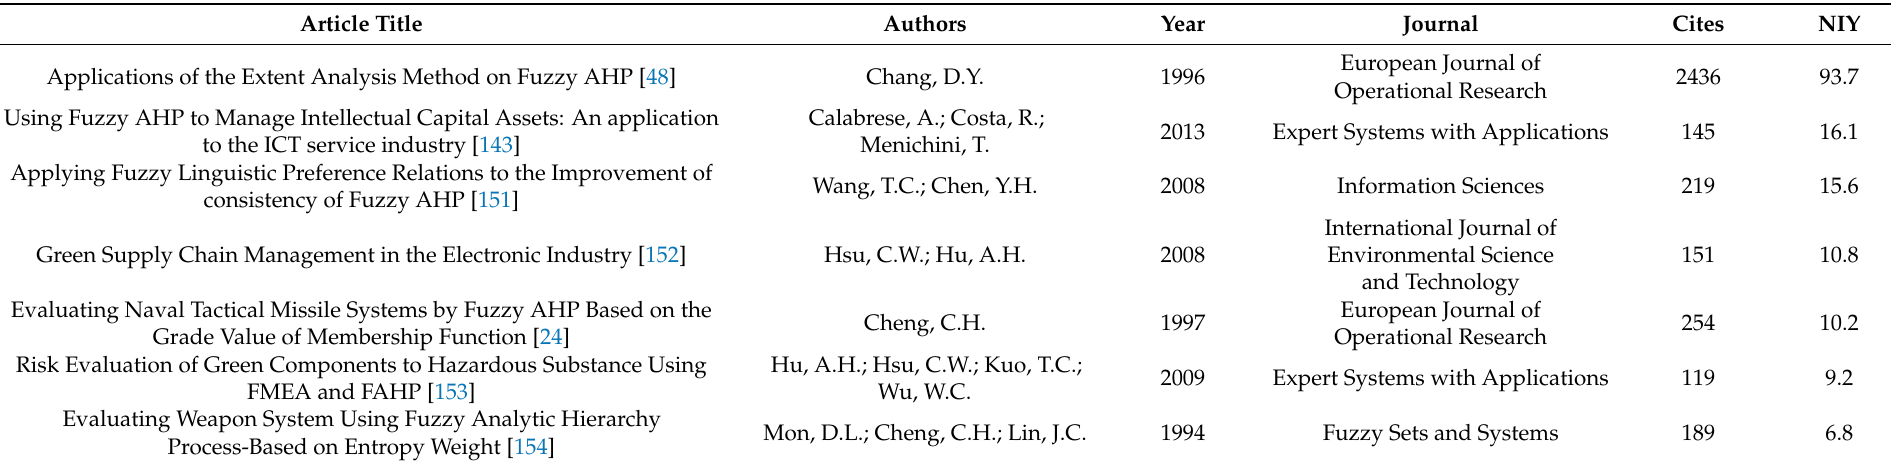
Table A5. Articles included in Cluster 5 sorted by NIY.